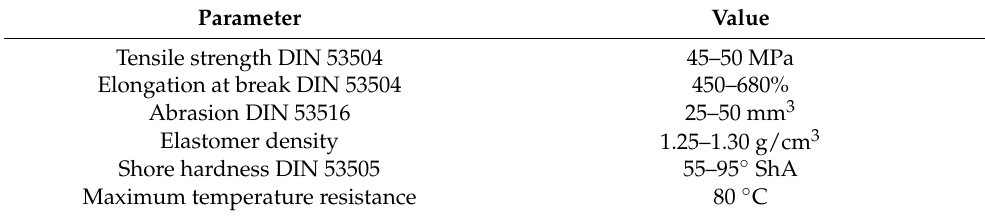
Table 3. Properties of the material (polyurethane) used as specimens in the study.